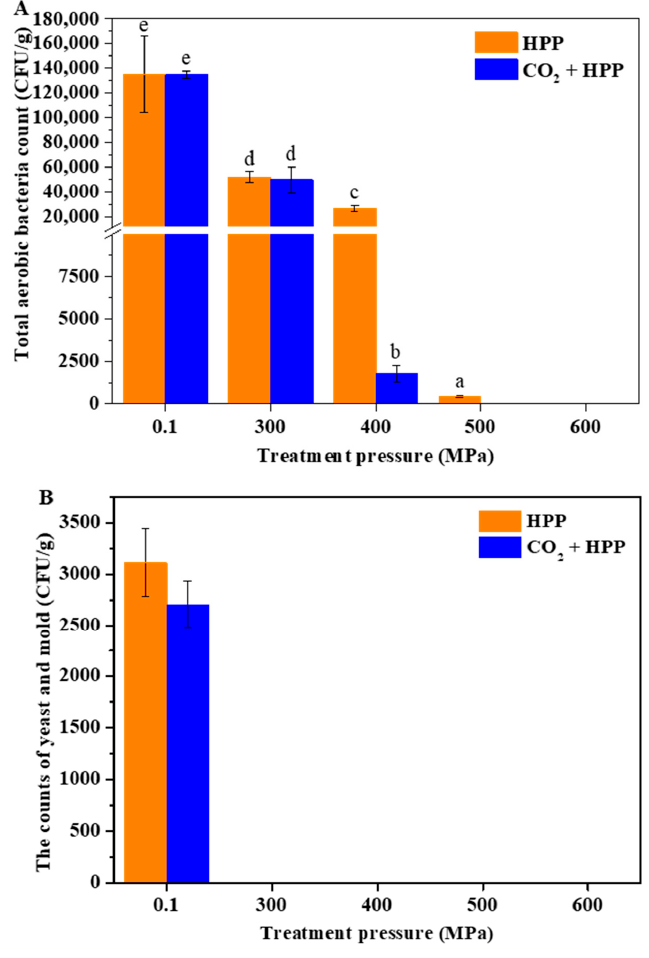
Figure 1. Effects of HPP and CO 2 + HPP treatments with different pressures on total aerobic bacteria ( A ) and yeast plus mold ( B ) counts of DFP. Different letters (a, b, c, etc.) indicate significantly different means at p < 0.05 (analysis of variance (ANOVA)).